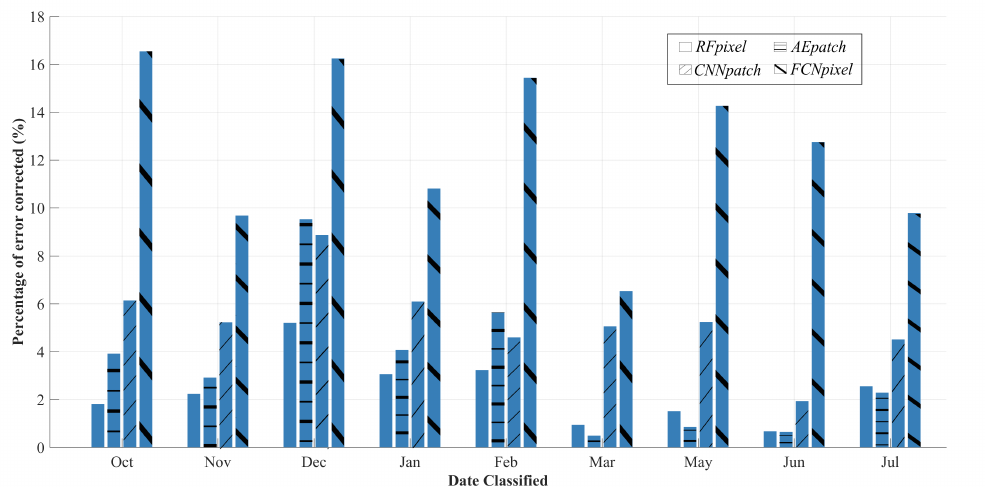
Figure 13. Percentage of error corrected by MLCS. From left to right in each bar-group RFpixel , AEpatch , CNNpatch , and FCNpixel ,